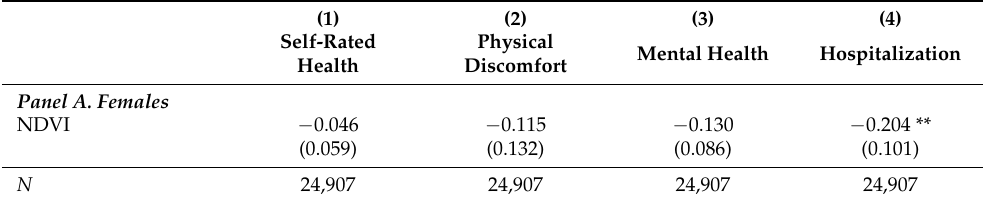
Table 5. Heterogeneous effect of greenspaces by